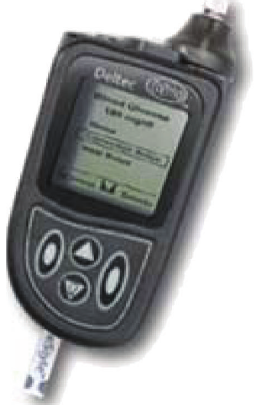
Figure 6: An image shows a fingerstick meter reading. In the use of the sensor, first o ff , cut the tip of a finger or earlobe bleeding. Then put the blood on a blood glucose sensor, which is a protuberance at the bottom of the module. The result is shown on the display in the middle-top of the